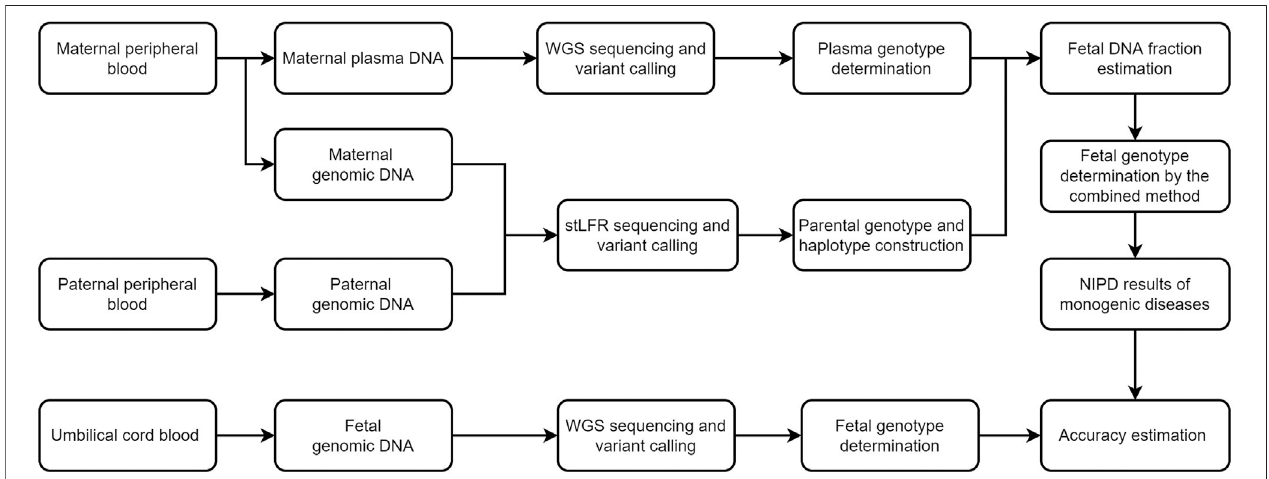
FIGURE1| Schematicofthisstudy.We fi rstrecruited fi vefamiliesandperformedstLFRsequencingofparentalgenomicDNAandgenomesequencingofcell-free DNA in maternal plasma. The fetal genome was successfully inferred using a combination of Bayesian- and haplotype-based prediction. Genome sequencing of fetal DNA in umbilical cord blood was used to determine the accuracy of our genotype inferences. WGS, whole genome sequencing, NIPD, non-invasive prenatal diagnosis; stLFR, single-tube long fragment reads.